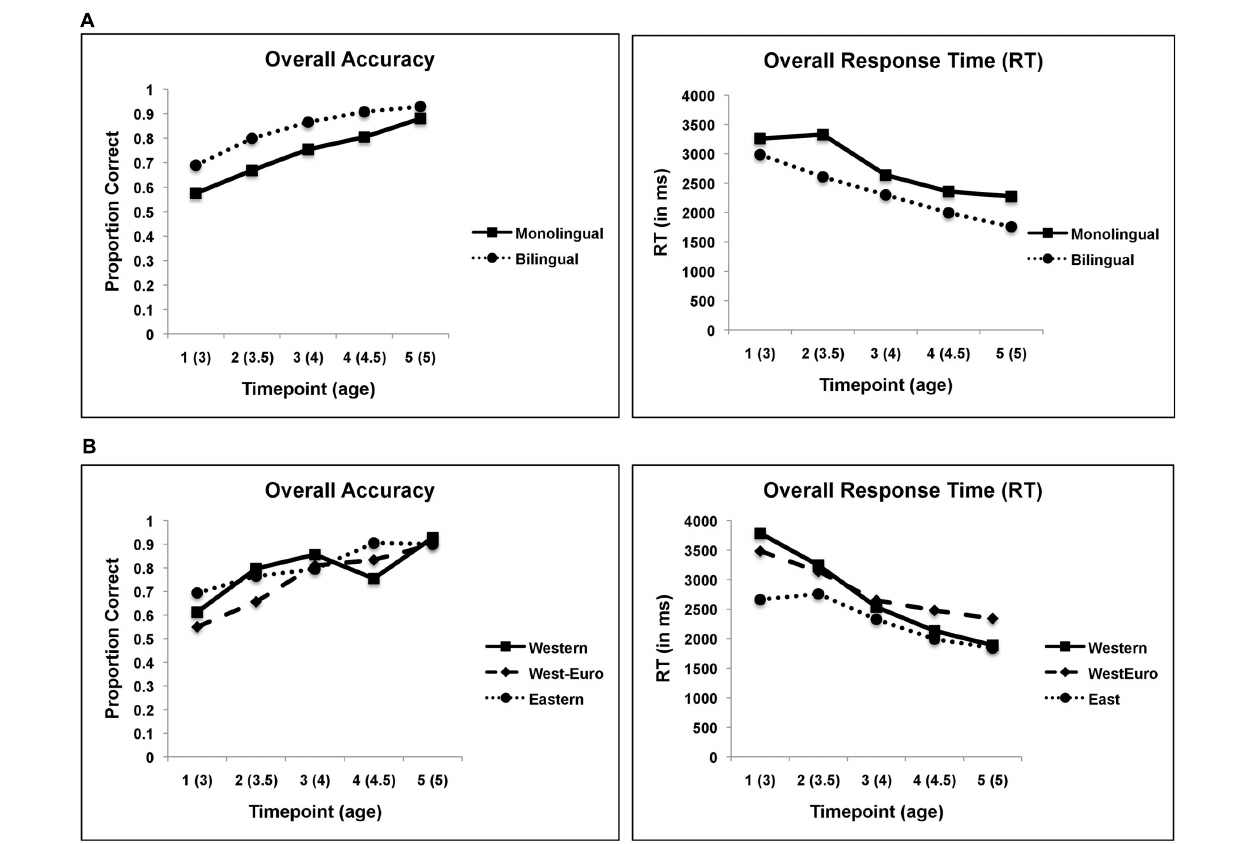
FIGURE 2 | Overall task performance (accuracy and RT) across all time points by (A) Language Group and by (B) Culture